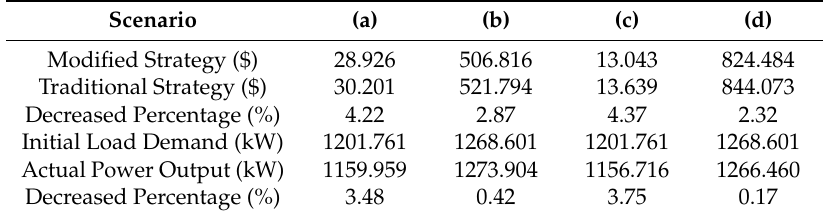
Table 3. Comparison of the modified and traditional strategy for CCHP.